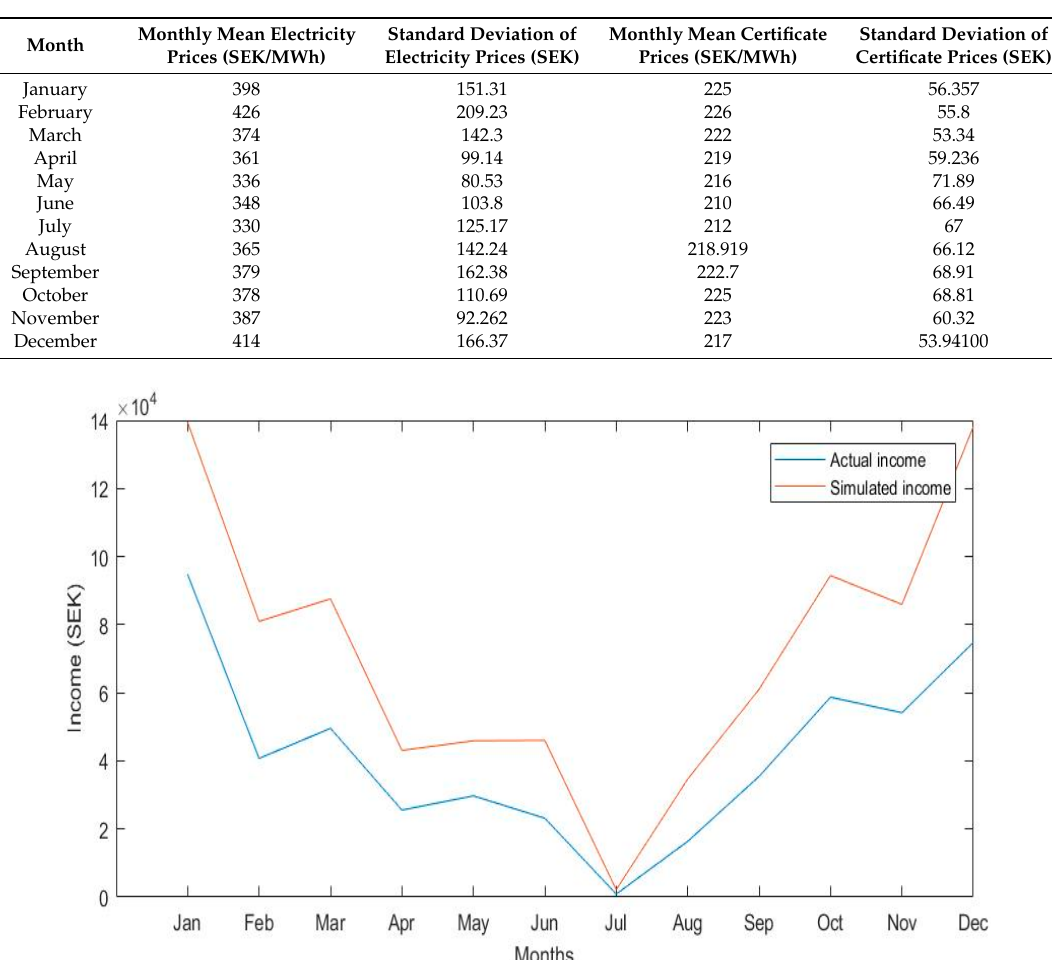
Figure 21. Actual and simulated income of the wind farm. Table 7. Parameters for Monte-Carlo simulation.